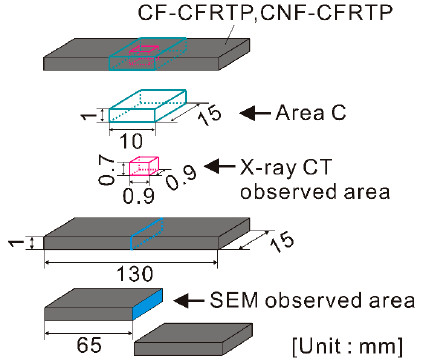
Figure 4. Observed area of X-ray microscope and SEM.